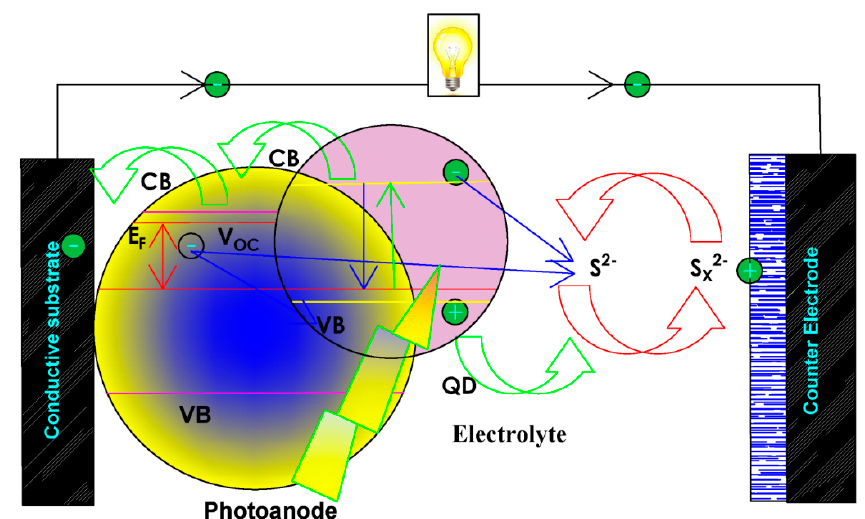
Figure 1. Schematic illustration of quantum dot solar cells (QDSCs) working procedure involving, quantum dots (QDs) photosensitizer, counter electrode, photoanode, and electrolyte [12].